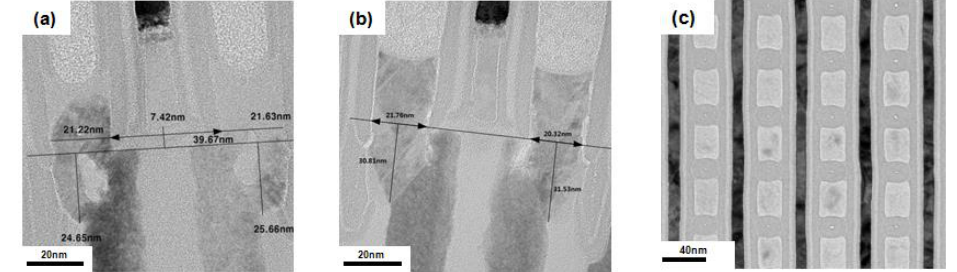
Figure 5. Cross-section transmission electron microscope (X-TEM) images of the gate buried contact (gBC) pattern after Si growth and etch-back. Si is grown by ( a ) thermal CVD with the amino-silane seeding and ( b ) MW-CVD. ( c ) A plan view TEM image of the Si grown by MW-CVD in the gBC pattern.